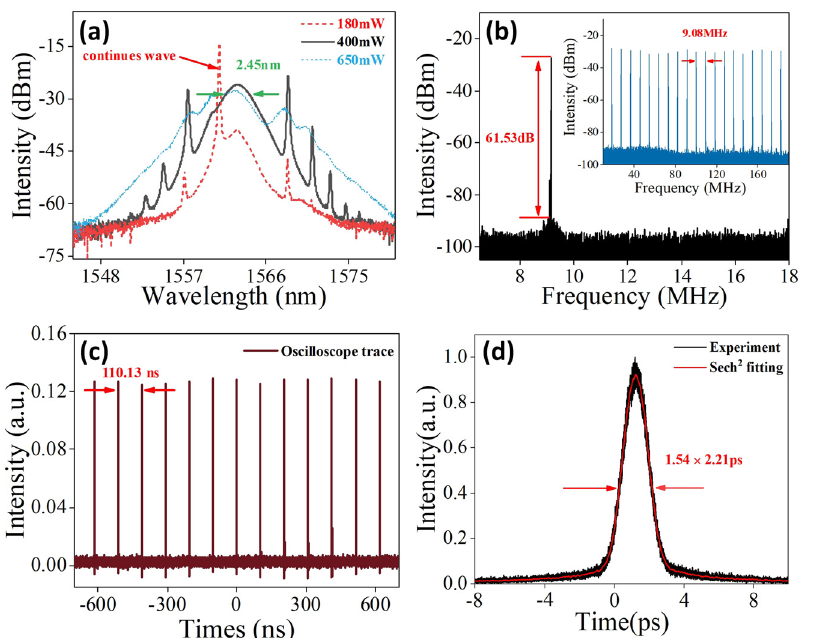
Figure 7: Mode-locking characteristics of soliton, (a) the optical spectra of soliton state, (b) the RF spectrum of soliton state, (c) mode-locked pulse trace of soliton state at 400 mW, (d) autocorrelation trace of soliton state at 400